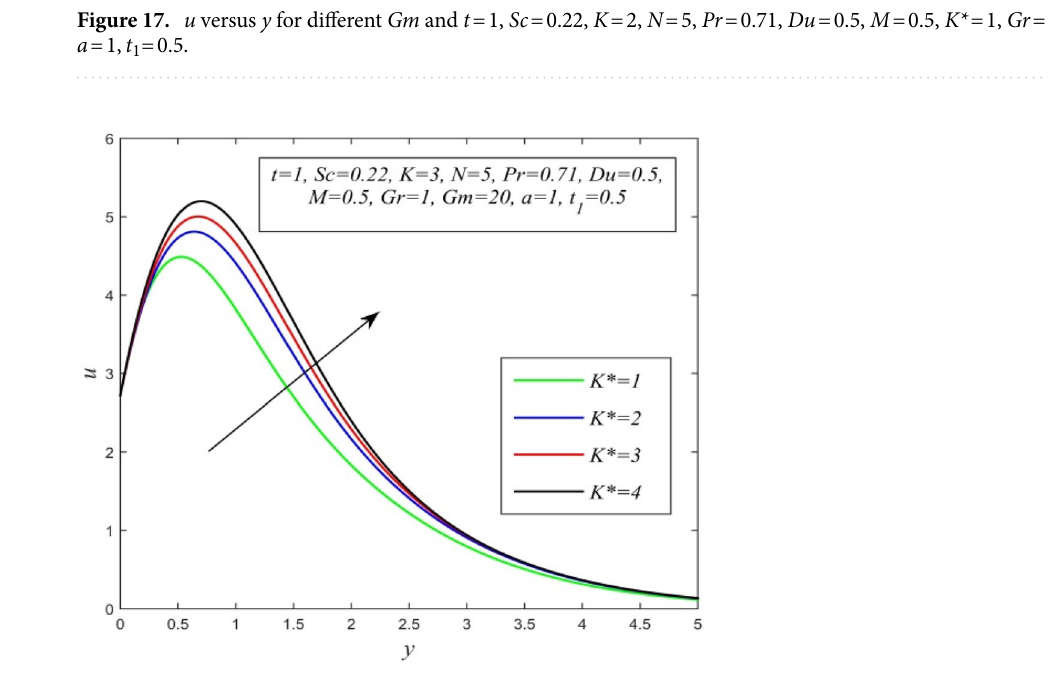
Figure 18. u versus y for different K* and t = 1, Sc = 0.22, K = 3, N = 5, Pr = 0.71, Du = 0.5, M = 0.5, Gr = 1, Gm = 20, a = 1, t 1 =